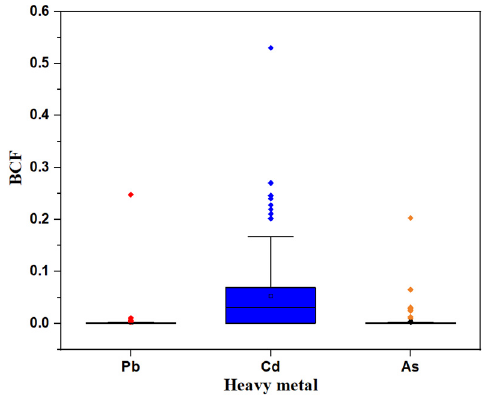
Figure 6. The bioconcentration factor of three heavy metals including Pb, Cd, and